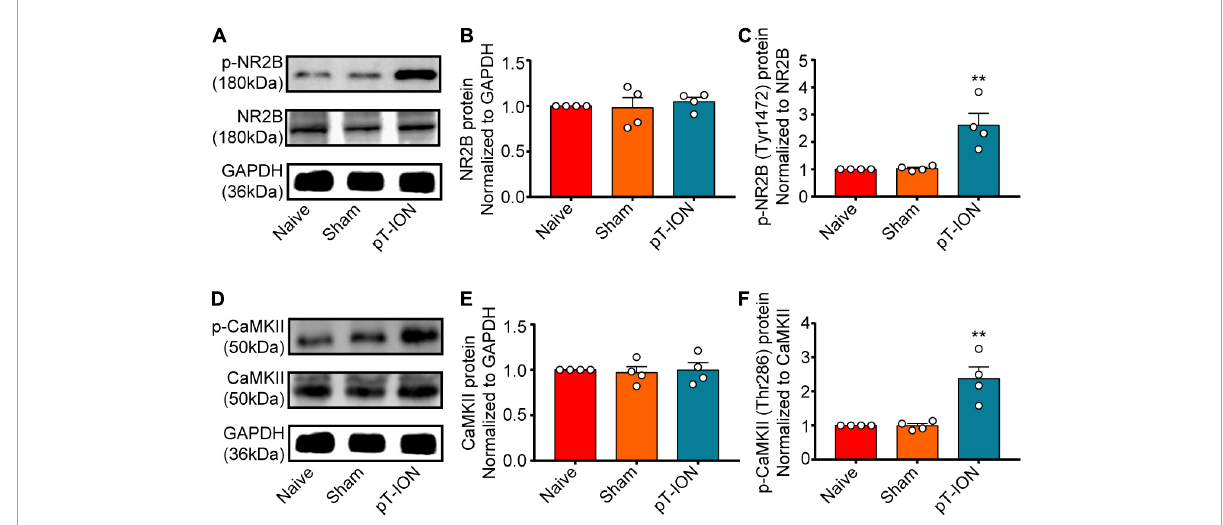
FIGURE3 The expression of p-NR2B and p-CaMKII on post-pT-ION day 21. The NR2B, p-NR2B, CaMKII and p-CaMKII protein expression in the Hb was shown by the representative blots (A,D) . The quantitative results were shown by the histograms (B,C,E,F) . N = 4 mice per group, ** p < 0.01 compared with the Naive